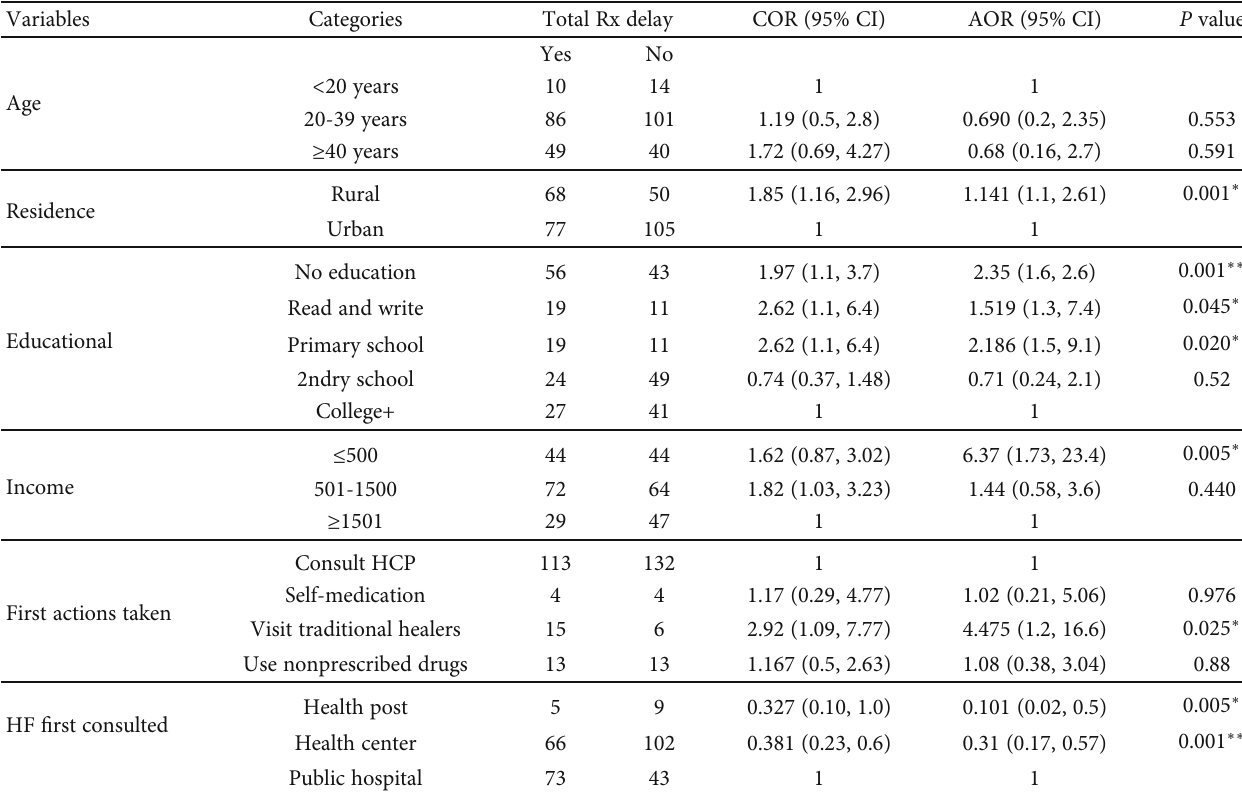
Table 3: The result of logistic regression showing association of variables with total delay for TB treatment at Debremarkos town public health facilities, North West Ethiopia,